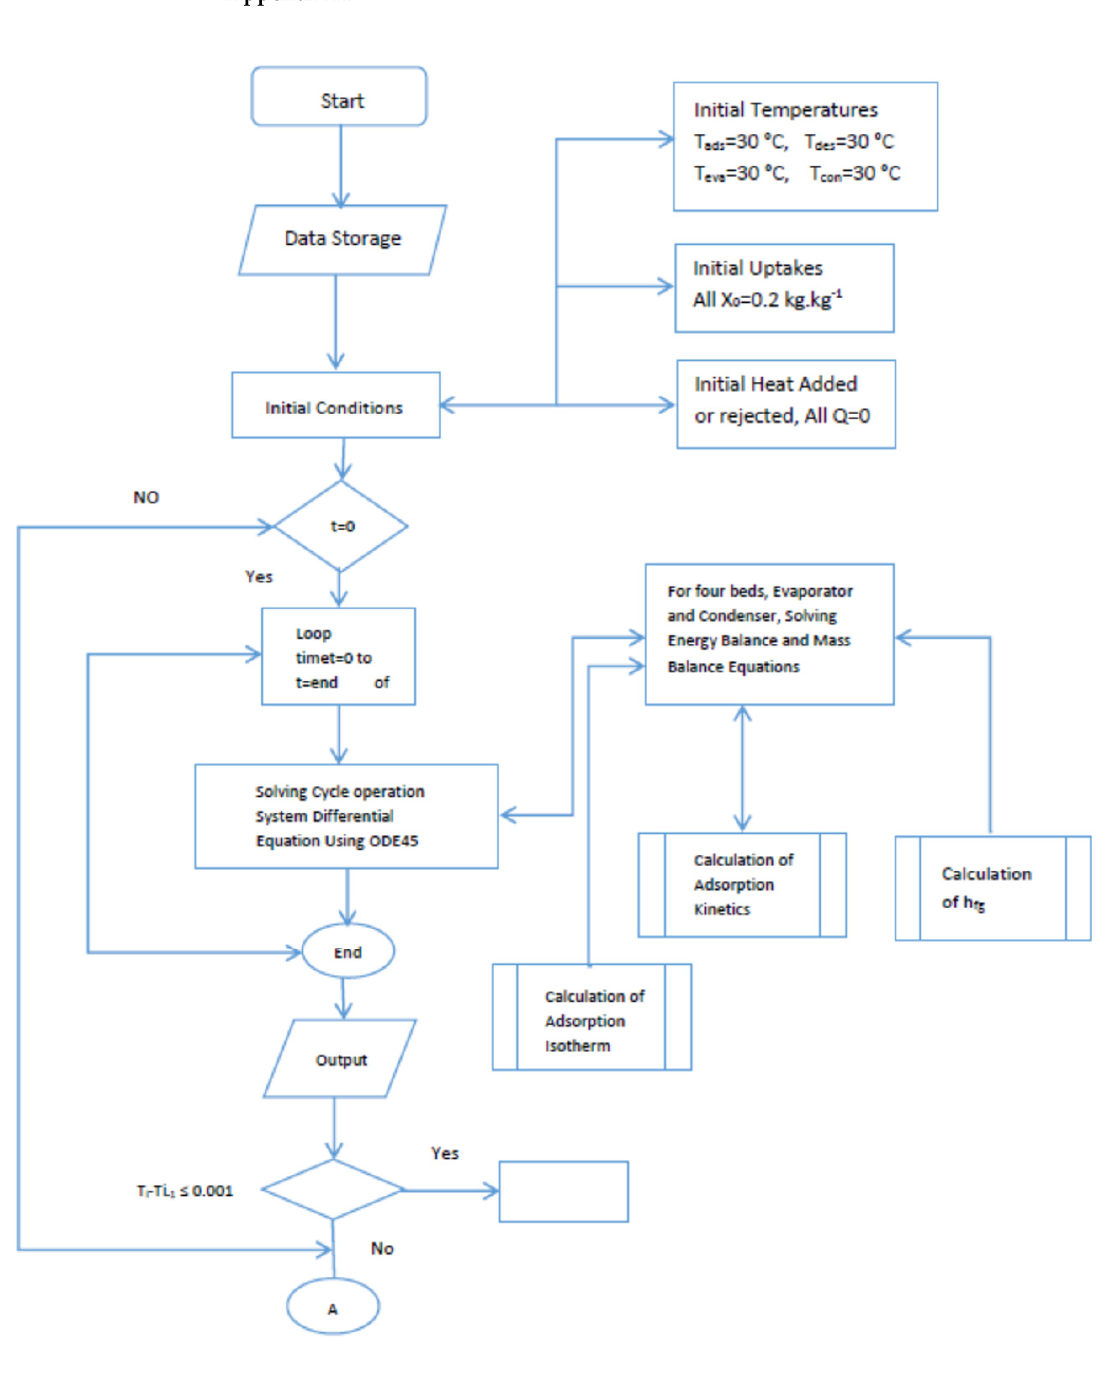
Figure A1. Flow chart for the simulation.